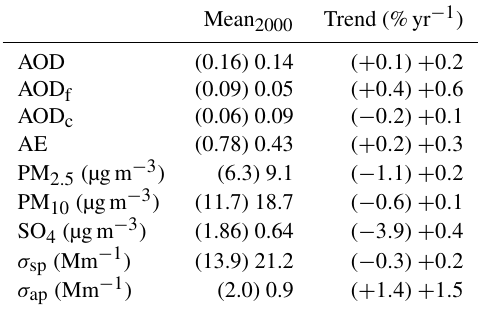
Table 4. Global means and trends of aerosol parameters using NorESM2 model data. The values in parentheses are obtained by aggregating only grid points where observation stations are located while using the complete model time series. The relative trends are calculated by averaging the absolute trends within the considered grid points and normalizing this average to the global mean for the year